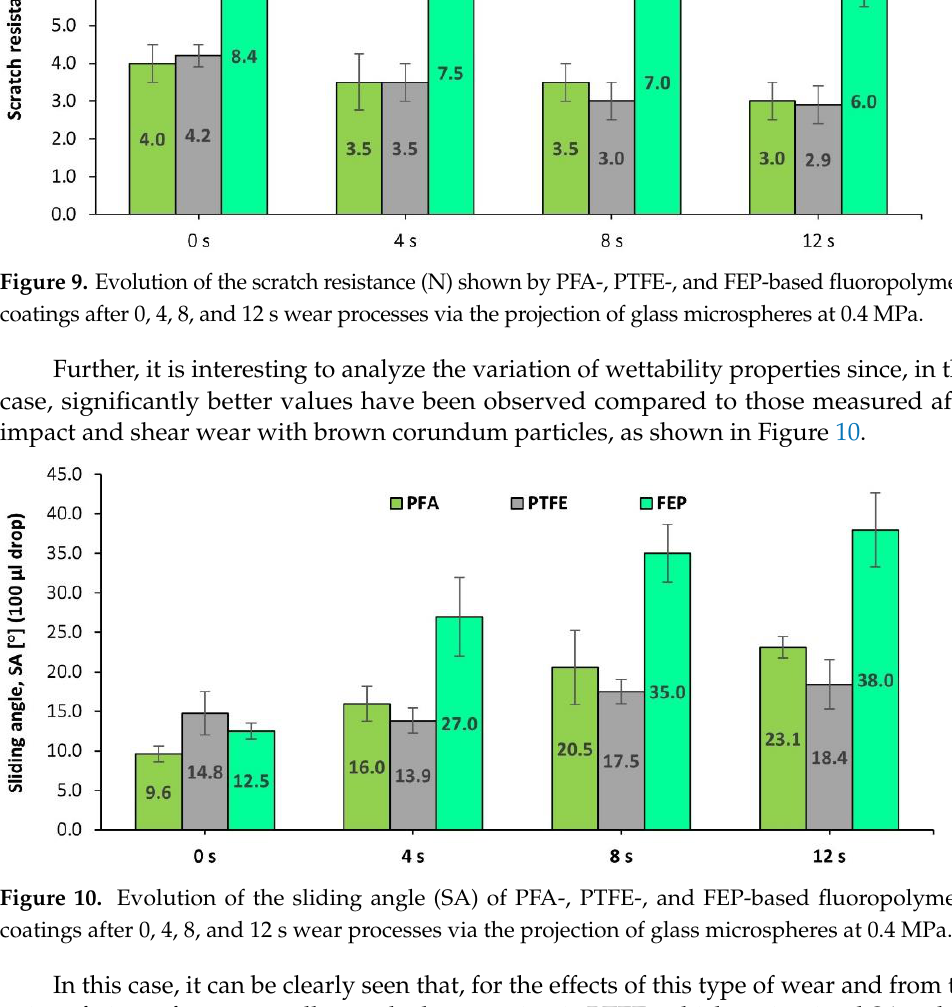
Table 5. Properties of fluoropolymeric coatings after 4 s of wear by plastic-polymeric particles pro- jected at 0.4